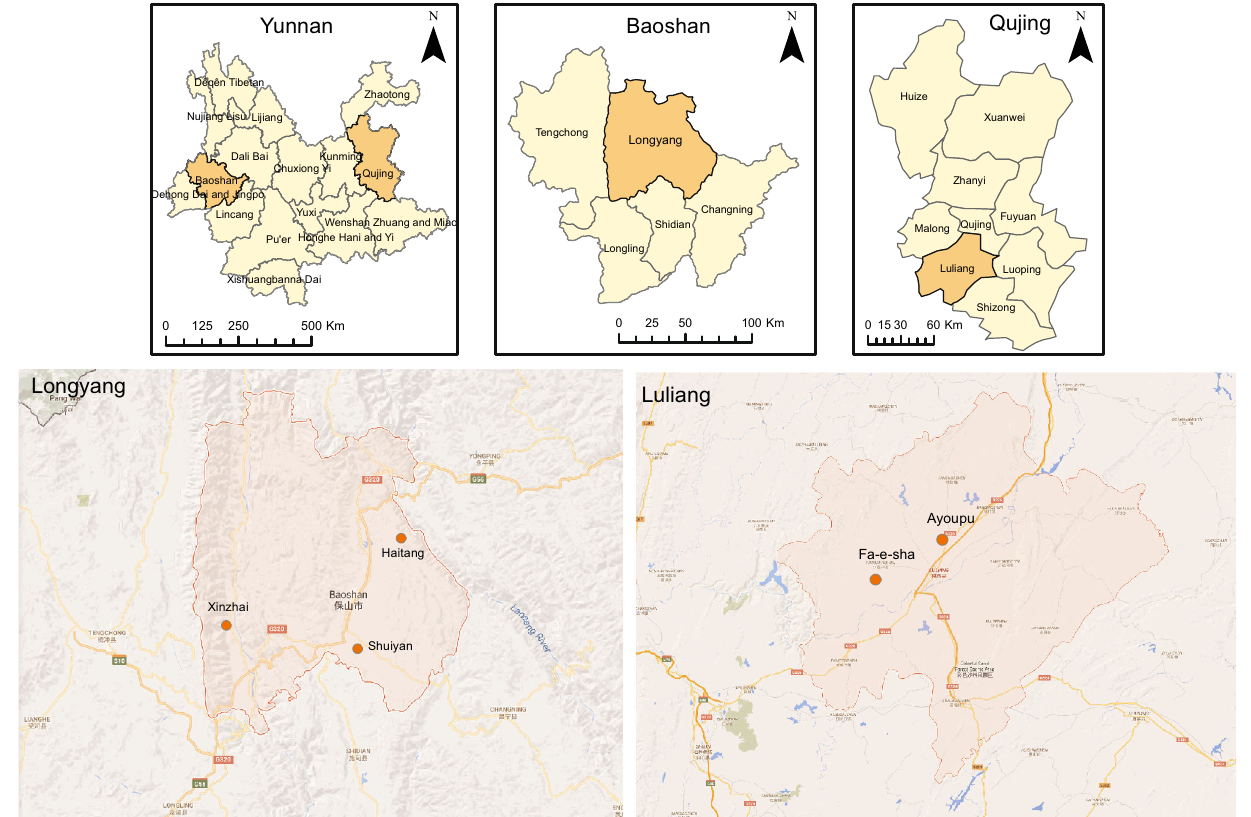
Fig. 1 Study areas in Yunnan Province, China. Source http://www.diva-gis.org and